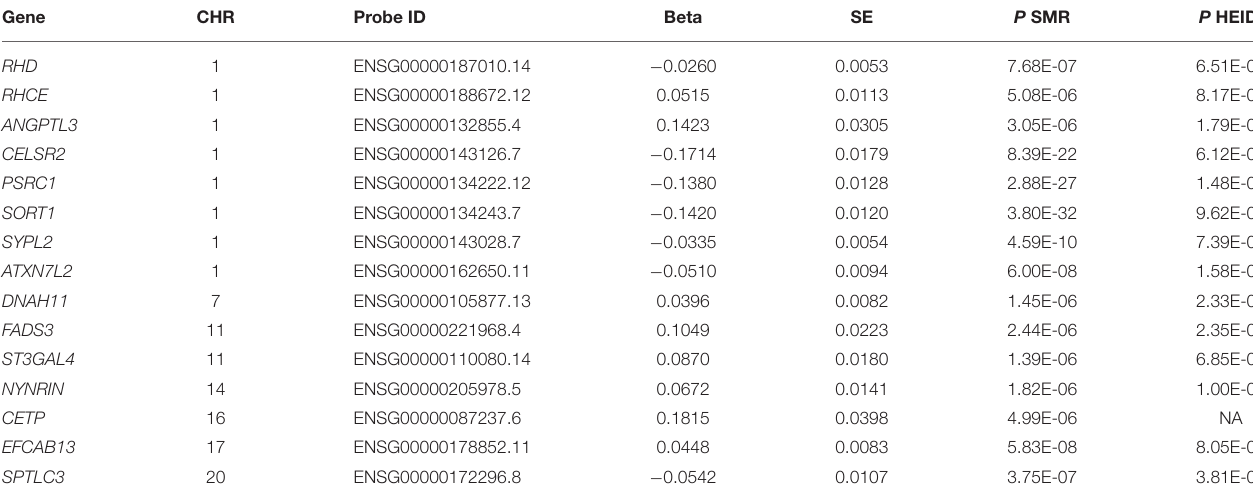
TABLE 2 | Liver cell gene expressions associated with circulating LDL-C